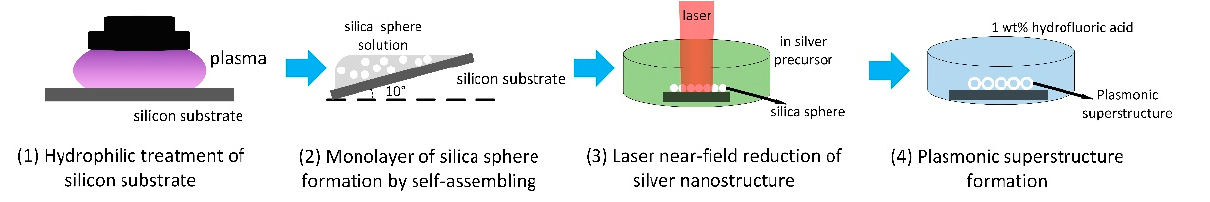
Figure 1. The schematic illustration for fabrication procedure of plasmonic superstructure, which includes.